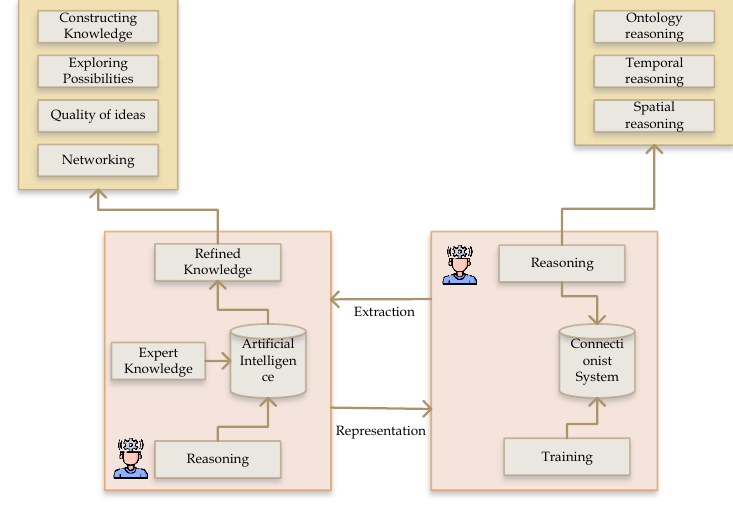
Figure 3. AI learning cycle